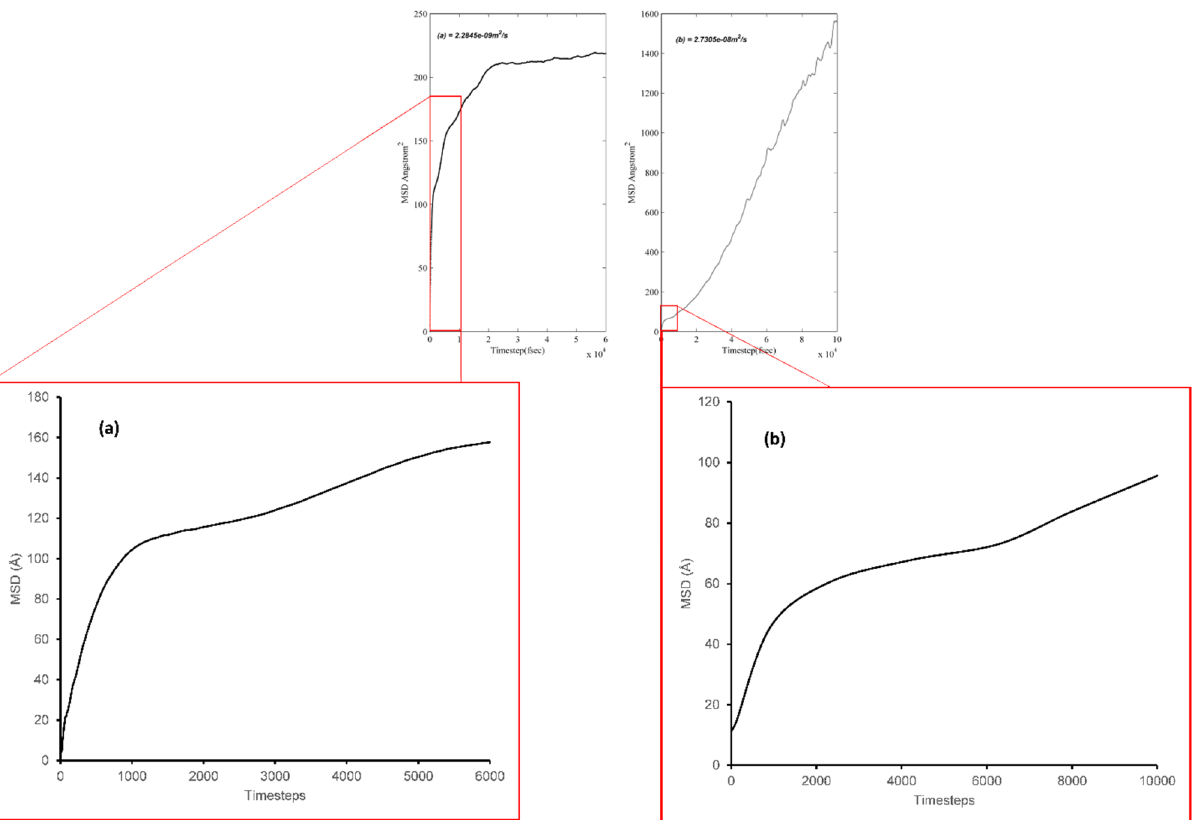
Figure 12. Diffusion coefficients of nanocluster CuO in water-based liquids: ( a ) diffusion coefficients of nanocluster CuO in water with BA (2.28e−09 m 2 /s); ( b ) diffusion coefficients of nanocluster CuO in water (2.73e−08 m 2